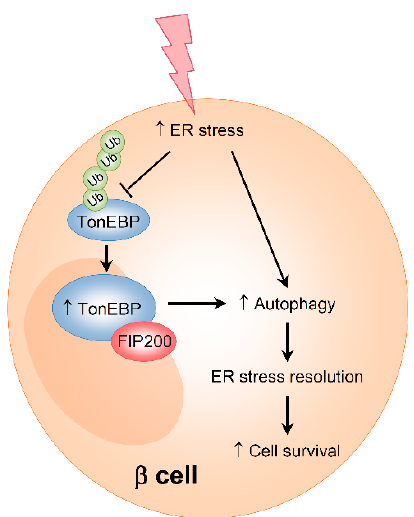
Figure 7. Model for ER stress-induced stabilization of TonEBP and autophagy formation in pancreatic β cells. TonEBP is deubiquitinated in response to ER stress. As a result, TonEBP is stabilized and interacts with FIP200 leading to the initiation of autophagy formation which prevents cell death.